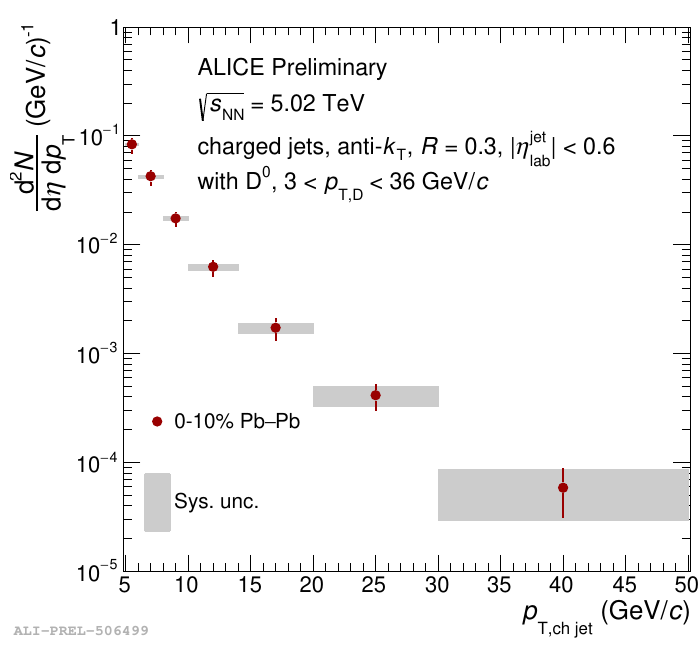
Figure 1. D 0 -jet momentum fraction distribution measured in pp collisions at √ s = 5 . 02 TeV. Vertical lines and boxes are, respectively, statistical and systematic uncertainties [4]. Jet and D 0 p T increase in panels from left to right and R increases in panels from top to bottom. Data are compared to predictions from models [3, 7–9]. Figure 2. D 0 -tagged jet p T -di ff erential yields in central (0–10%) Pb–Pb collisions at √ s NN = 5 . 02 TeV. The red vertical lines and gray boxes are, respectively, the statistical and systematic